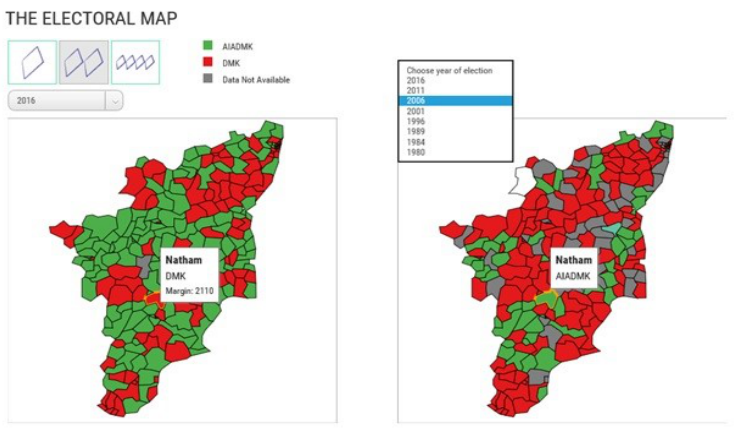
Figure 14: Comparison of Electoral Map for Tamil Nadu for Four Different Elections Provided Drop-Down Menus for Selection of Years (from